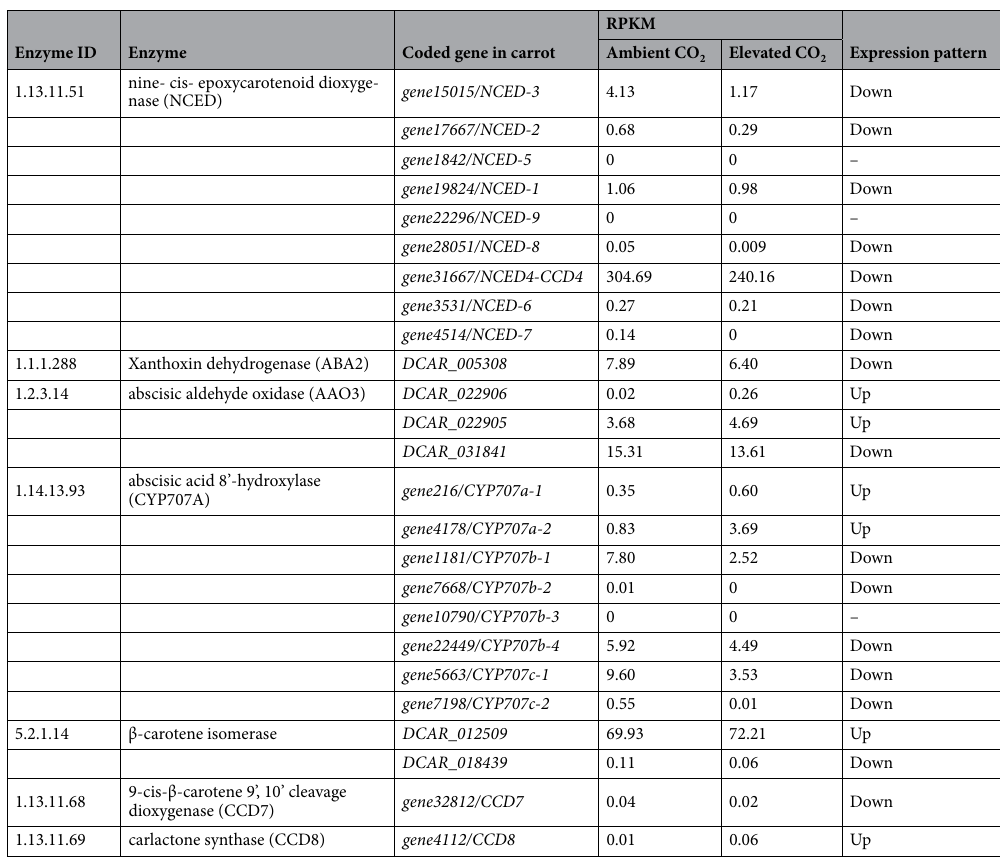
Table 5. Enzymes and coded genes of carotenoid degradation process.